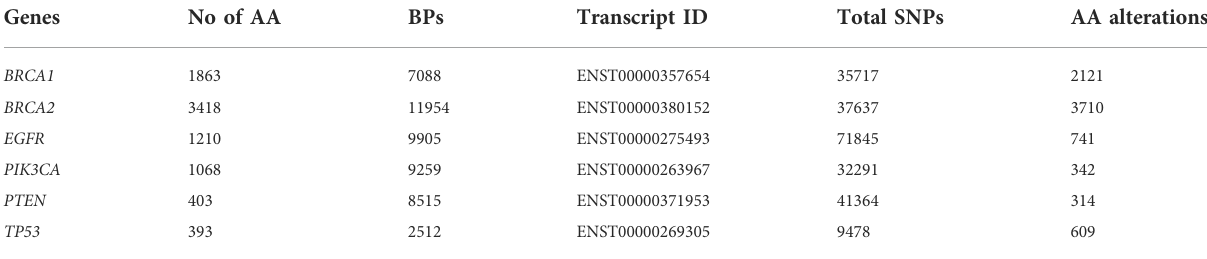
TABLE 1 Details of transcripts and SNPs of the recurrent genes identi fi ed by our